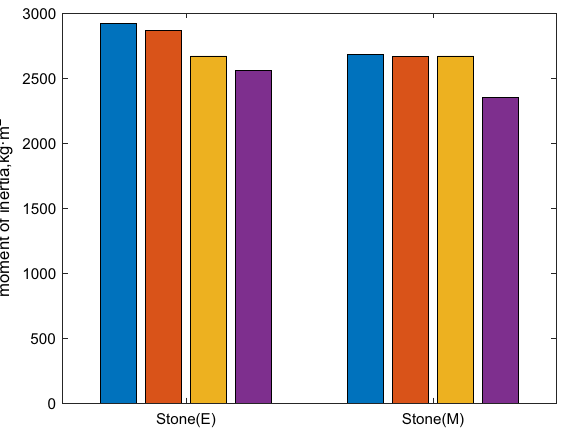
Figure 17. Results of identification